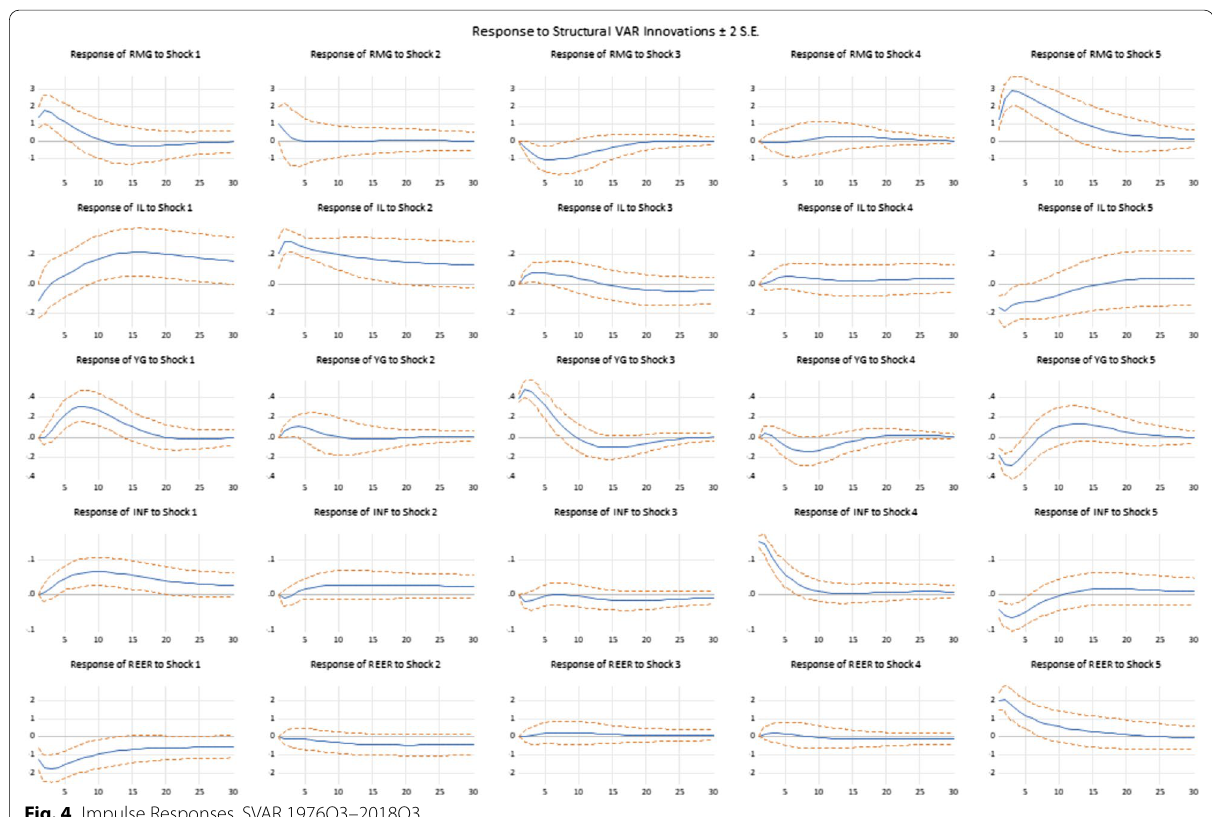
Fig. 4 Impulse Responses, SVAR